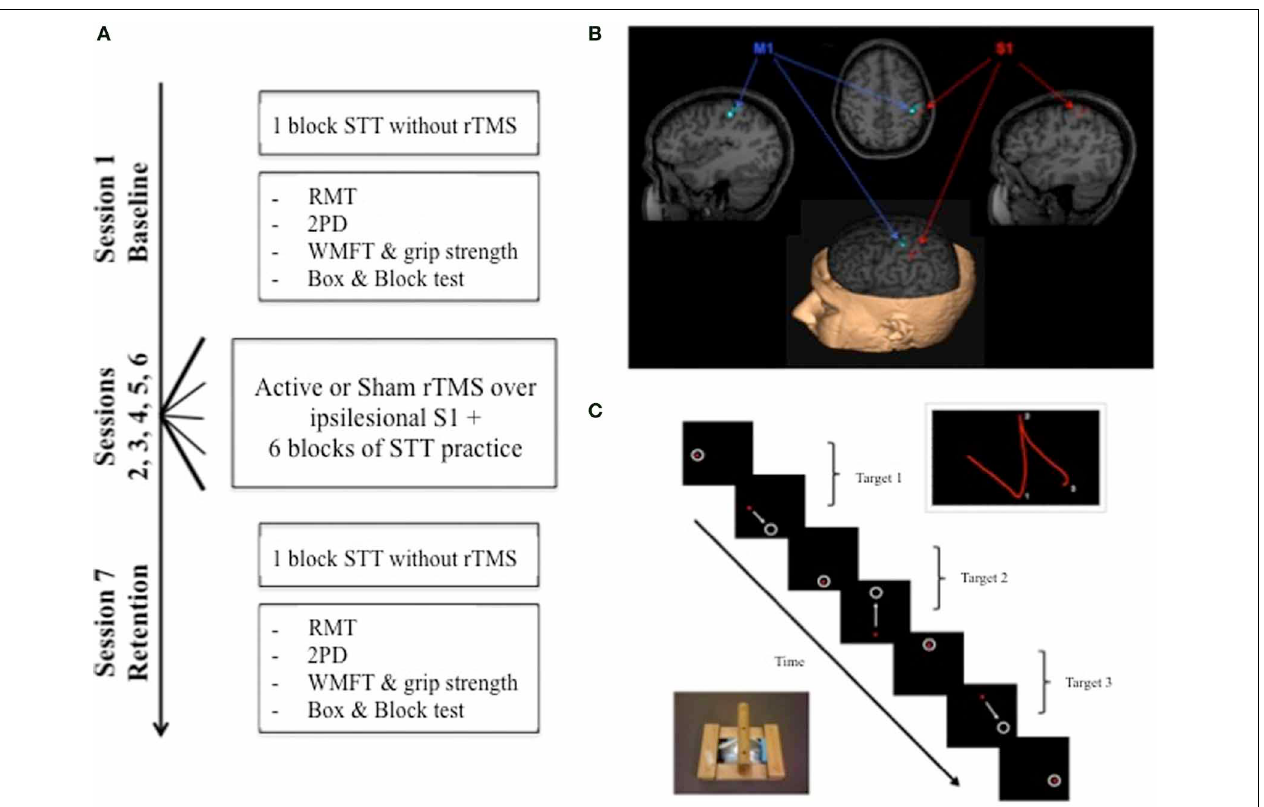
FIGURE 1 | (A) Experimental overview. At the baseline session on day 1, STT performance was assessed along with RMT, 2PD, WMFT, and Box & Blocks performance. Five sessions of rTMS paired with STT practice were completed on separate days (days 2–6). A delayed no-rTMS retention test was administered on a separate day 7 to assess motor learning; all baseline measures were re-assessed. (B) Example of target